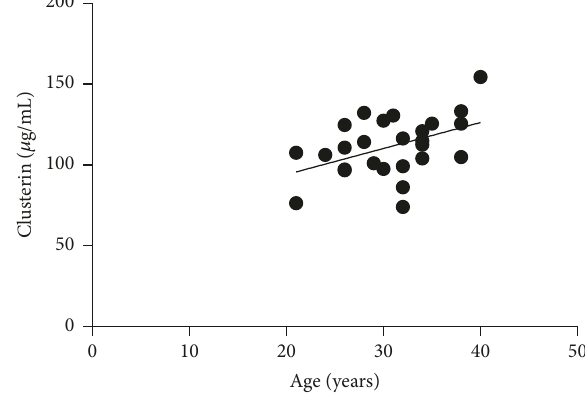
ANP, 𝑝 = 0.0850 ). Osteopontin levels of the two pregnant groups did not differ (3.037 [2.439 – 4.015] ng/mL in HP